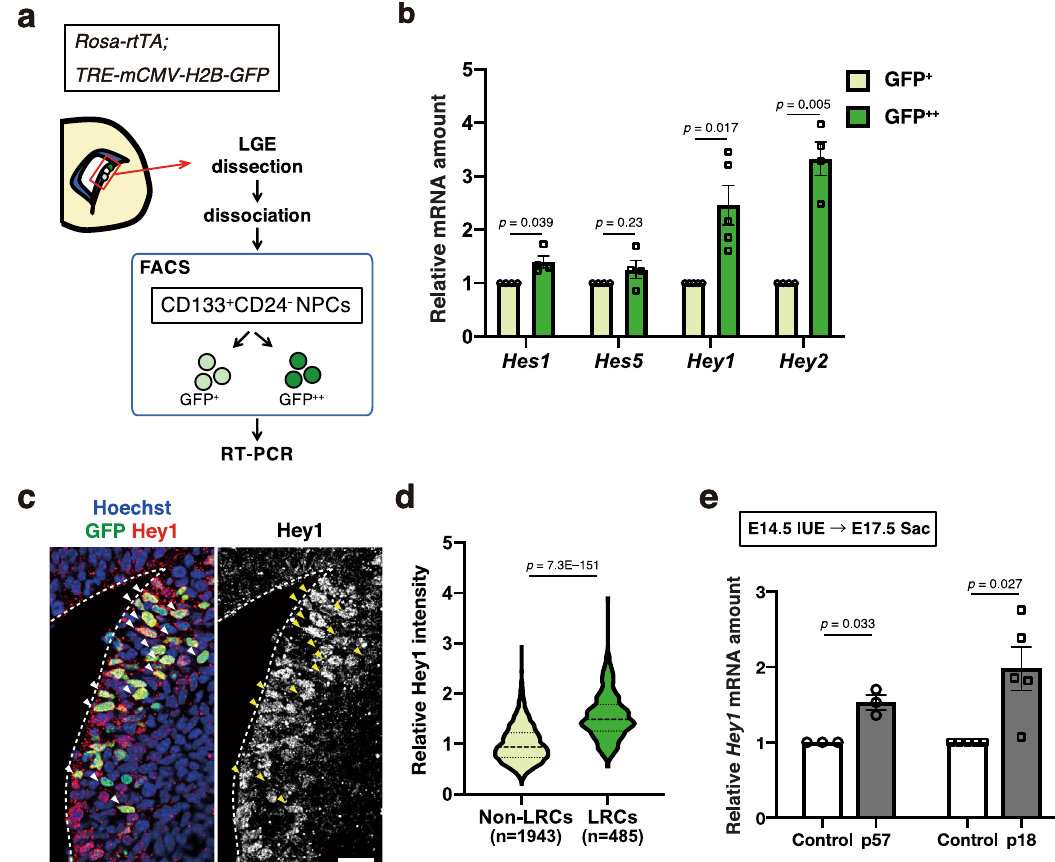
Fig. 3 Hey1 is highly expressed in slowly dividing embryonic NPCs. a Scheme for the isolation of slowly dividing and rapidly dividing NPCs from the LGE of Rosa-rtTA;TRE-mCMV-H2B-GFP embryos at E16.5 on the basis of H2B-GFP retention after exposure to 9TB-Dox at E9.5. Embryonic NPCs were de fi ned as CD133 + CD24 – cells and were subdivided into two populations based on H2B-GFP intensity — top 8% (GFP ++ ) and middle 40% to 65% (GFP + ) — by FACS for RT and real-time PCR analysis. b RT and real-time PCR analysis of the indicated Notch target genes in NPCs isolated as in a . Data were normalized by the amount of β -actin mRNA, are expressed relative to the corresponding value for GFP + cells, and are means ± SEM ( n = 4, 4, 5, and 4 independent experiments for Hes1 , Hes5 , Hey1 , and Hey2 , respectively), two-tailed paired t test. c Immunohistochemical analysis with antibodies to GFP and to Hey1 for sections of the LGE of Rosa-rtTA;TRE-mCMV-H2B-GFP embryos at E17.5 after exposure to 9TB-Dox at E9.5. Nuclei were stained with Hoechst 33342. Scale bar, 20 μ m. Dashed lines indicate the ventricular surface. Arrowheads indicate GFP-retaining slowly dividing cells. d Quanti fi cation of Hey1 staining intensity for the indicated numbers of LRCs and non-LRCs (top 15% and bottom 60% of NPCs for H2B-GFP staining intensity, respectively) in the LGE at E17.5 for sections as in c . Data are expressed relative to the corresponding value for non-LRCs. Violin plots show the median (horizontal dashed line) and quartiles (horizontal dotted lines) ( n = 1943 and 485 cells for non-LRCs and LRCs, respectively). Eight brain sections were analyzed per embryo, two-tailed Student ’ s t test. e RT and real-time PCR analysis of Hey1 expression in cells positive for CD133 and GFP and negative for CD24 isolated by FACS from the neocortex of E17.5 embryos that had been subjected to in utero electroporation at E14.5 with plasmids for GFP alone (control) or together with p57 or p18. Data were normalized by the amount of β -actin mRNA, are expressed relative to the corresponding value for control, and are means ± SEM for n = 3 independent experiments for p57 or n = 5 independent experiments for p18, two-tailed paired t